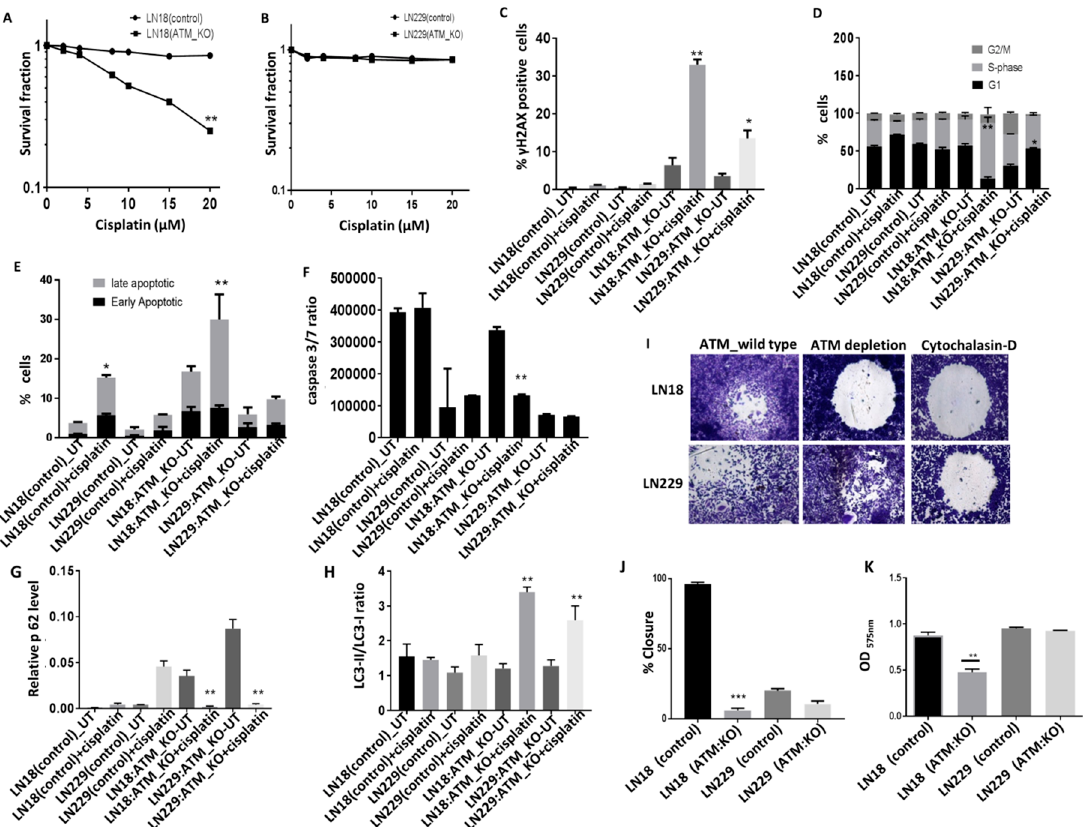
Figure 5. ATM depletion and platinum sensitivity. ( A ) Cisplatin sensitivity in LN18 control and ATM KO cells. ( B ) Cisplatin sensitivity in LN229 control and ATM KO cells. ( C ) LN18 control, LN229 control, LN18 ATM KO and LN229 ATM KO were treated with cisplatin for 48 h and γ H2AX levels were analysed by flow cytometry. ( D ) Cell cycle analysis by flow cytometry for LN18, LN229 control and ATM KO cells treated with cisplatin. ( E ) Annexin V analysis by flow cytometry in LN18, LN229 control and ATM KO cells treated with cisplatin. ( F ) caspase 3/7 ratio by chemiluminescence detection in LN18, LN229 control and ATM KO cells treated with cisplatin. ( G ) p62 protein levels by western blotting in LN18, LN229 control and ATM KO cells treated with cisplatin. ( H ) LC3I and II protein levels by western blotting in LN18, LN229 control and ATM KO cells treated with cisplatin. ( I ) Representative photomicrographic images for migration assay for LN18and LN229 control and ATM KO cells. CytochalasinD (migration inhibitor 1.5 µ M) was used as a negative control. ( J ) percentage closure quantification by imageJ software. ( K ) Invasion assay in LN18, LN229 control, and ATM KO cells. * p value < 0.05, ** p value < 0.01, *** p value <